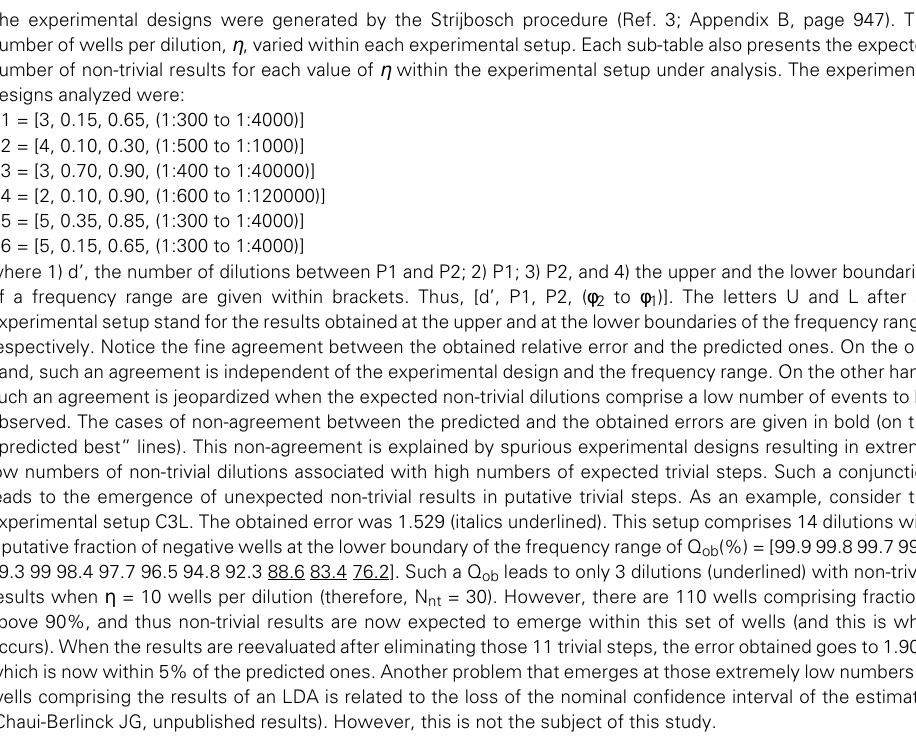
Table 1 - Comparison between the relative error obtained and those predicted both by the best procedure (equations 6a and b) and by the approximate procedure (equation 8) for a series of different experimental designs. The experimental designs were generated by the Strijbosch procedure (Ref. 3; Appendix B, page 947). The number of wells per dilution, η , varied within each experimental setup. Each sub-table also presents the expected number of non-trivial results for each value of η within the experimental setup under analysis. The experimental designs analyzed